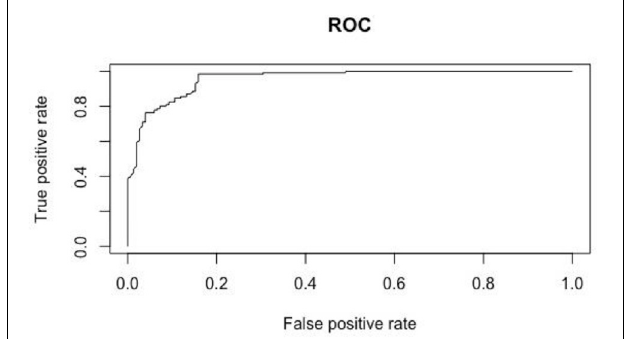
FIGURE 4 | Response curve of the predictions of model 2 in Table 3 showing the probability of nest presence versus distance from shoreline (m). forest model was also generated using a 10:1 ratio of pseudo- absence points to presence points, which had a lower sensitivity in comparison to the model created using an equal ratio ( Table 5 ).